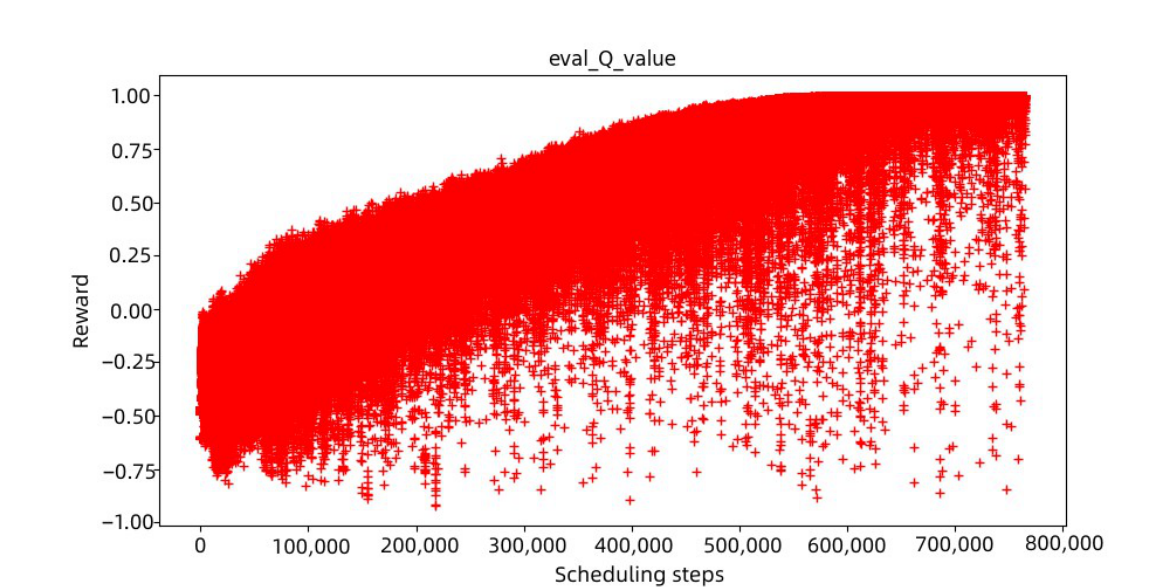
Figure 2. Reward value curve of single-step scheduling policy training process.